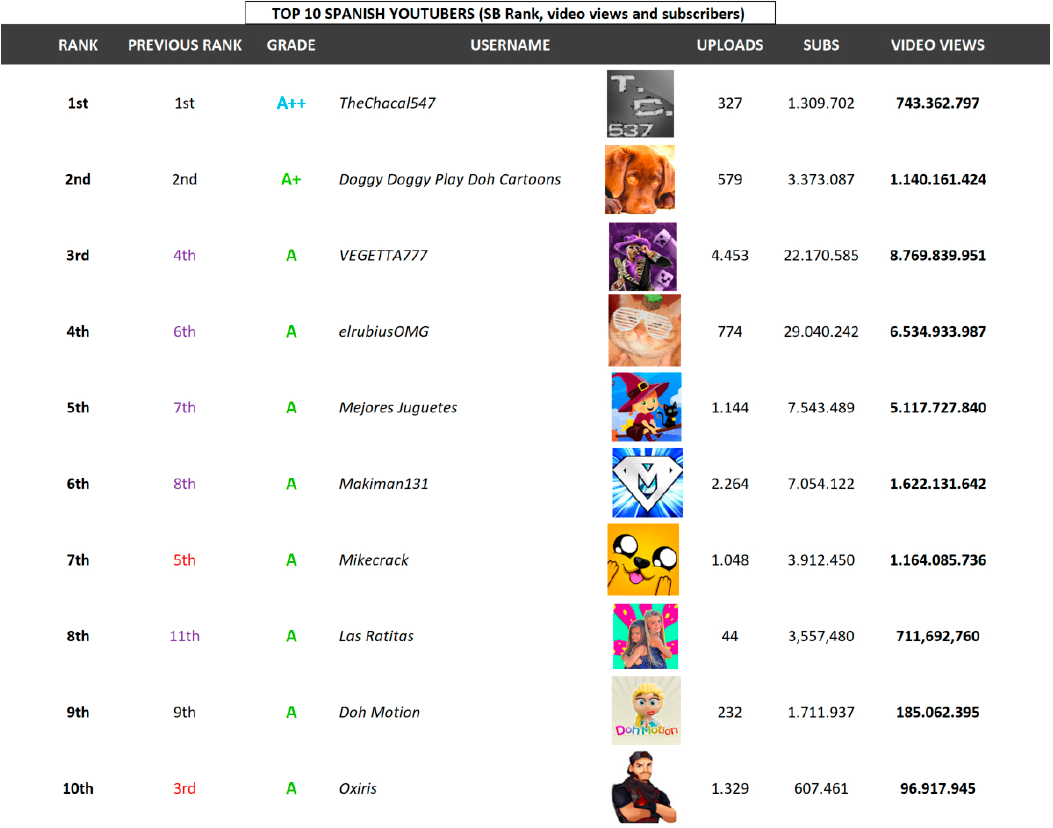
Figure 10. Social Blade ranking of 10 top Spanish YouTubers in descending order: SB Rank, video views, and subscribers.